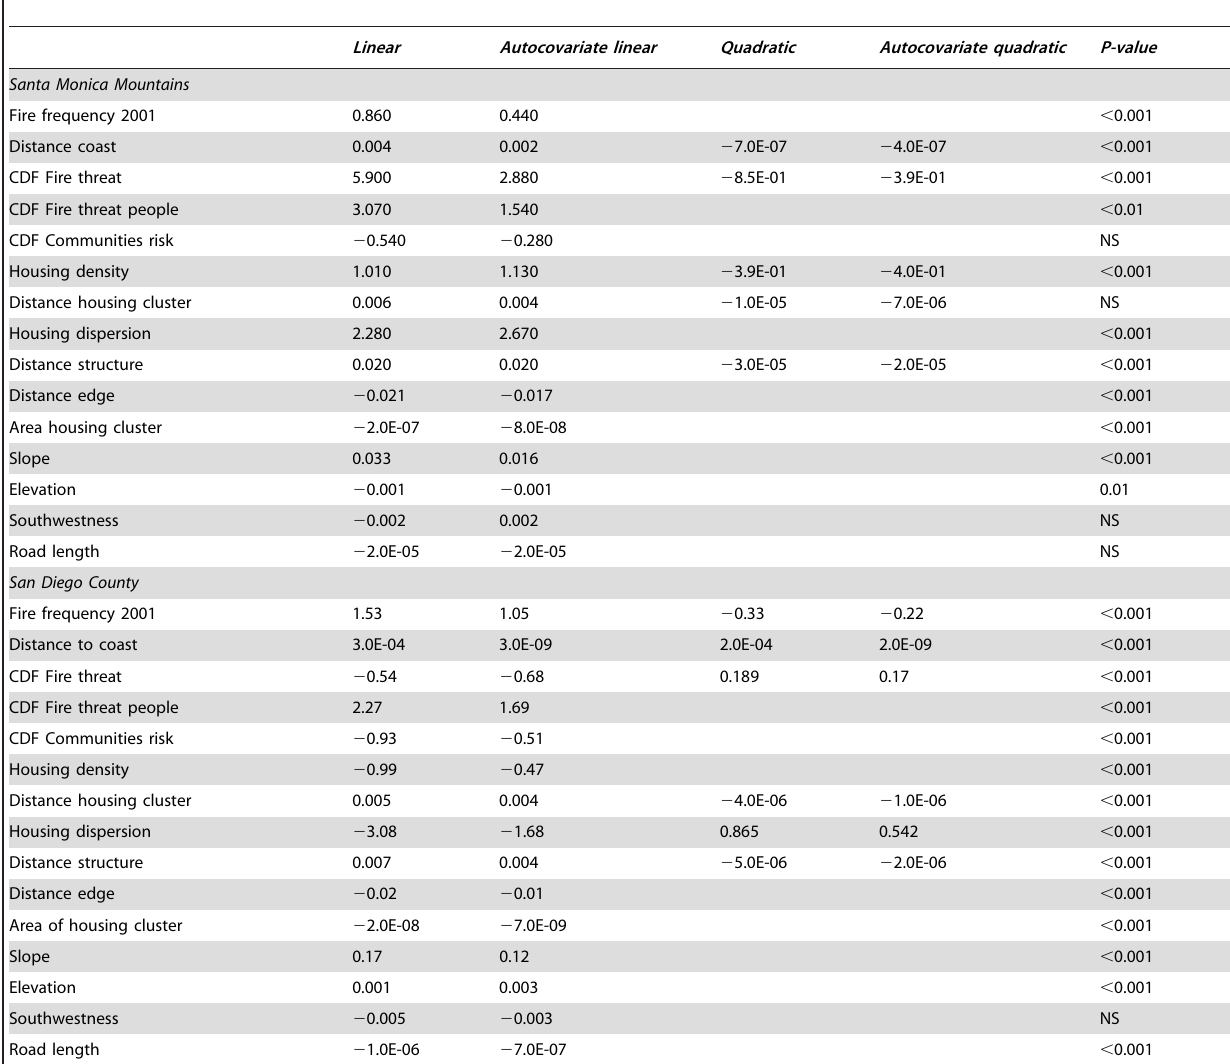
Table 2. Model coefficients for generalized linear models (GLMs) estimated with and without autocovariate terms in the Santa Monica Mountains and San Diego